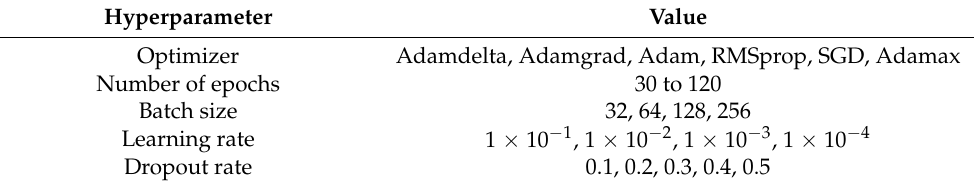
Table 3. Hyperparameters used for tuning the 2D convolutional neural network (CNN) model. Hyperparameter